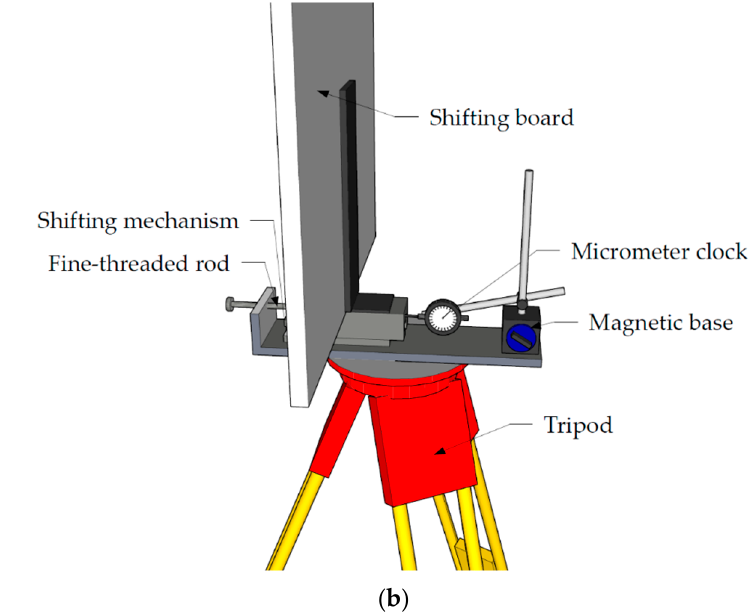
Figure 3. Shift test board setup: ( a ) wooden board on tripod; ( b ) Bahco micrometer with a magnetic base.